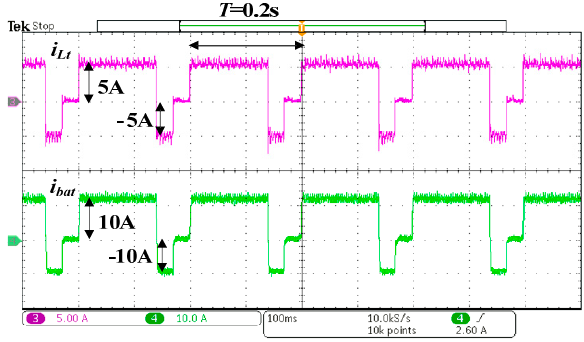
Figure 9. Measured reflex charging waveform of the proposed high-gain RC-BDC.